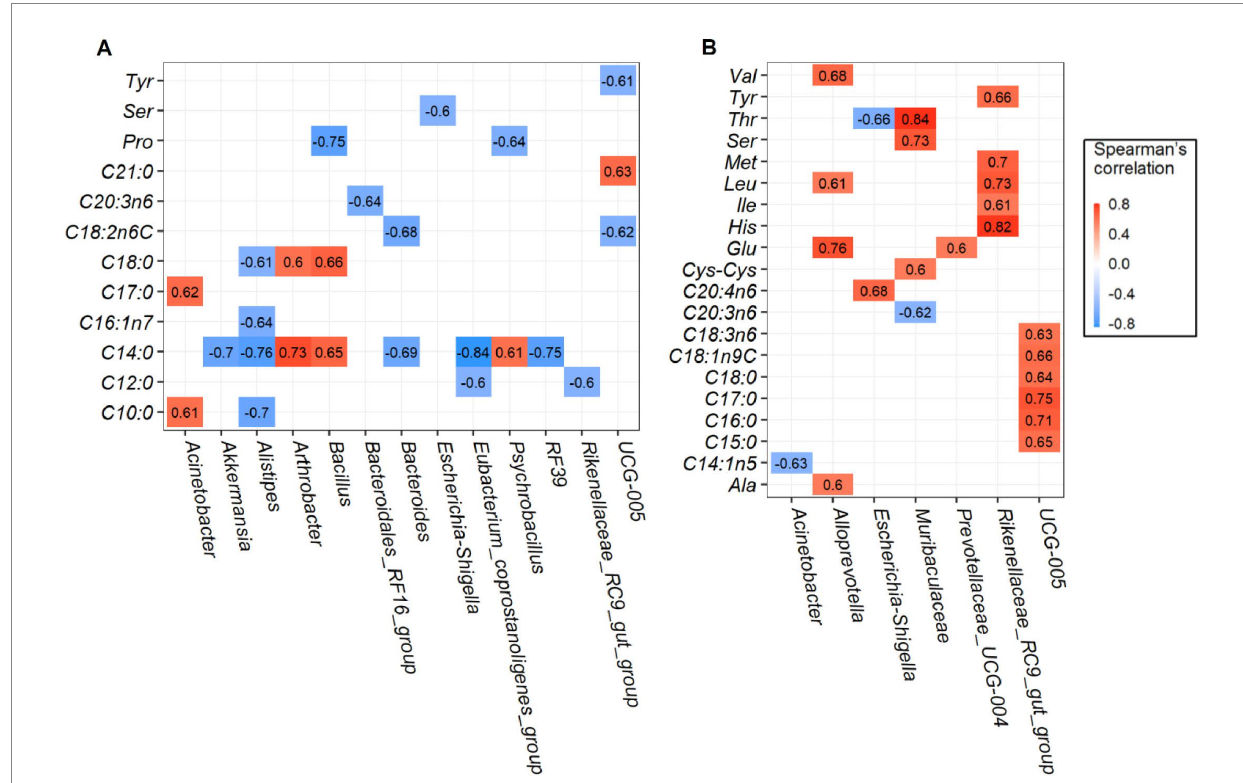
FIGURE 4 Correlation analysis between the rumen bacteria and amino acids and fatty acids. Significant correlations between the content of top 20 genera and amino acids and fatty acids in longissimus dorsi (A) , and semimembranosus (B)